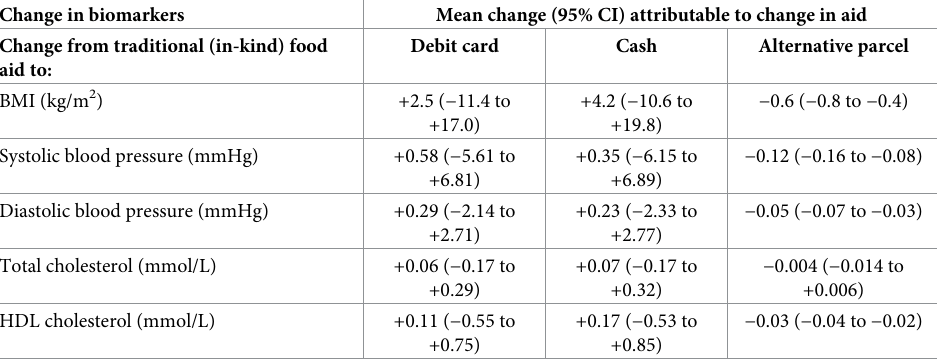
Table 4. Estimated changes in biomarkers from a change in food aid. Model-derived estimates of changes in dietary intake measures attributable to a change from food parcel to electronic debit card delivery of food aid; a change